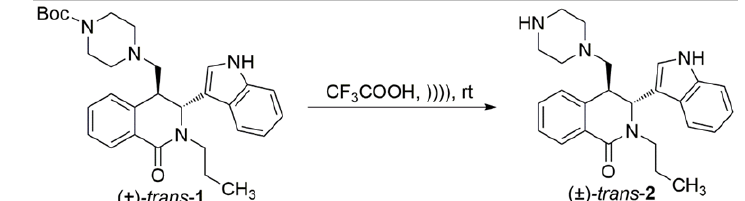
Figure 1. Representative chemical synthesis routine of active compounds trans - 1 and trans - 2 . ( A ) Synthetic strategy of trans - 1 . The reagents and conditions for each step numbered i to v are presented below the scheme. ( B ) The BOC − piperazine group of trans - 1 was removed to obtain trans - 2 .